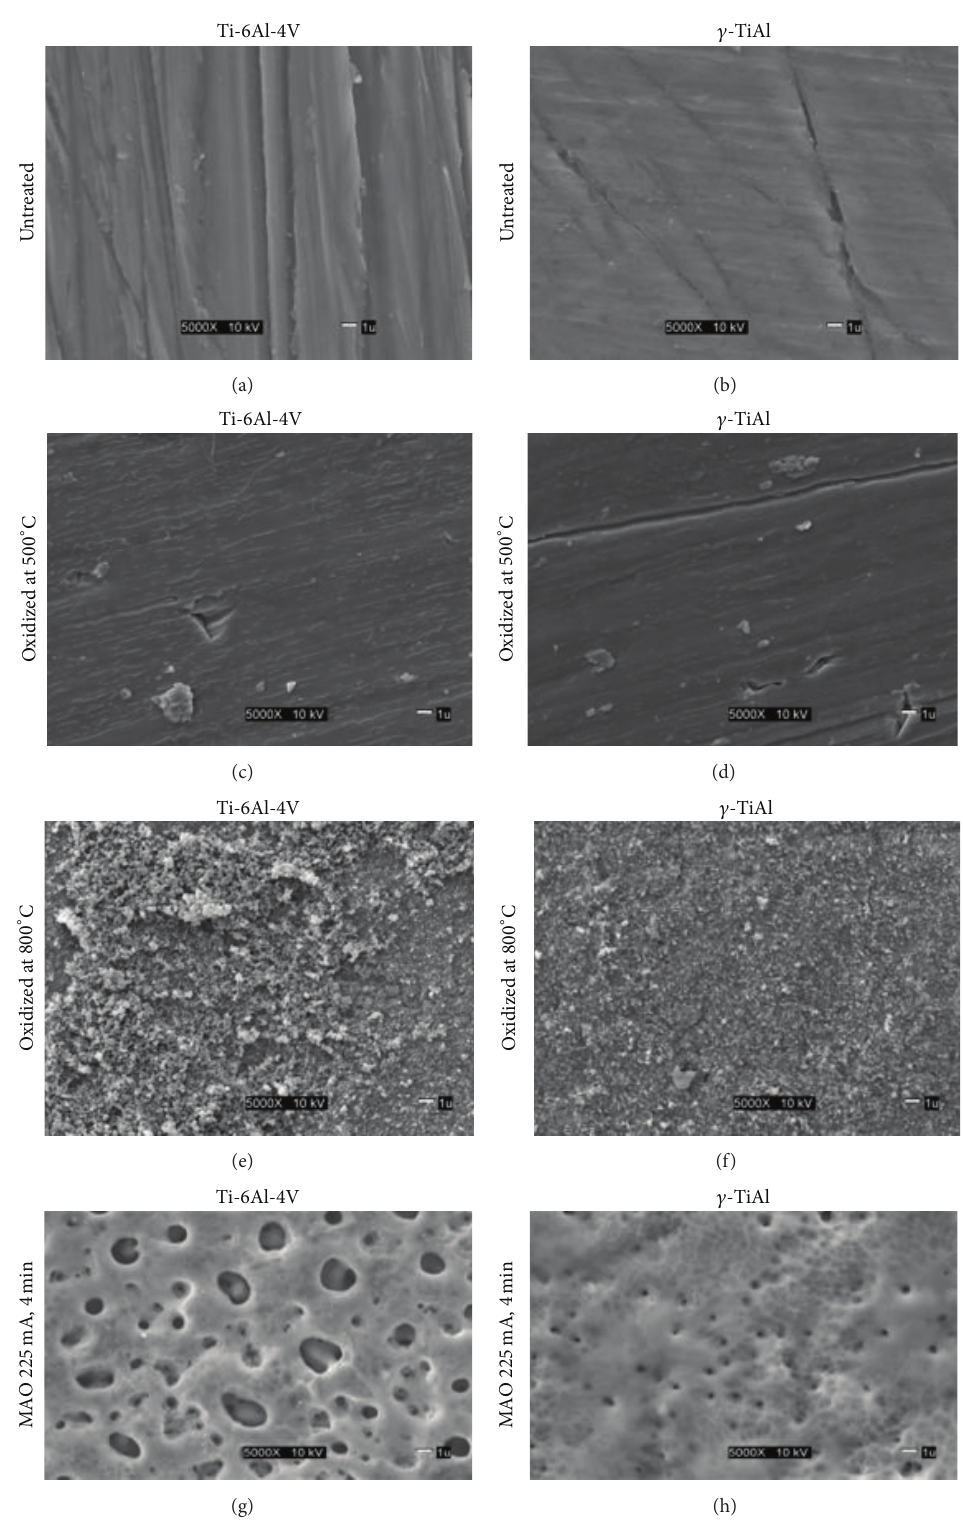
Figure 1: SEM images of Ti-6Al-4V and 𝛾 -TiAl alloys. (a), (b): untreated, (c), (d): oxidized at 500 ∘ C, (e), (f): oxidized at 800 ∘ C, and (g), (h): MAO at 225 mA,